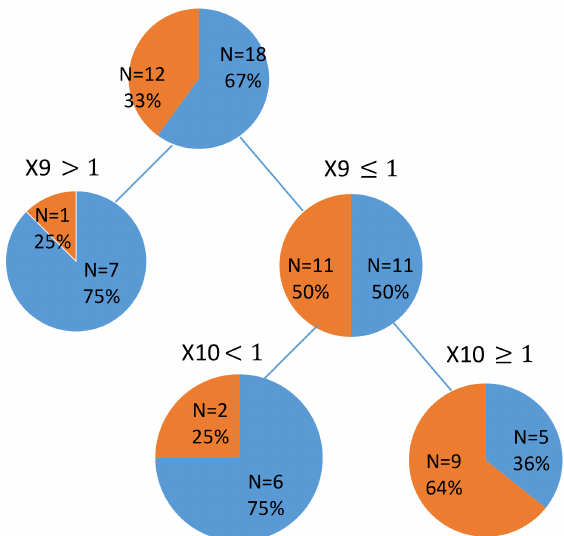
Figure A1. DT for the dental caries outcome in children identified by their parents’ clinical and microbiological data. (periodontal condition was eliminated, Exclude x8 and x3); children with dmft ≤ 10; children with dmft > 10; X9: Perio Check (parent); X10: Perio Check